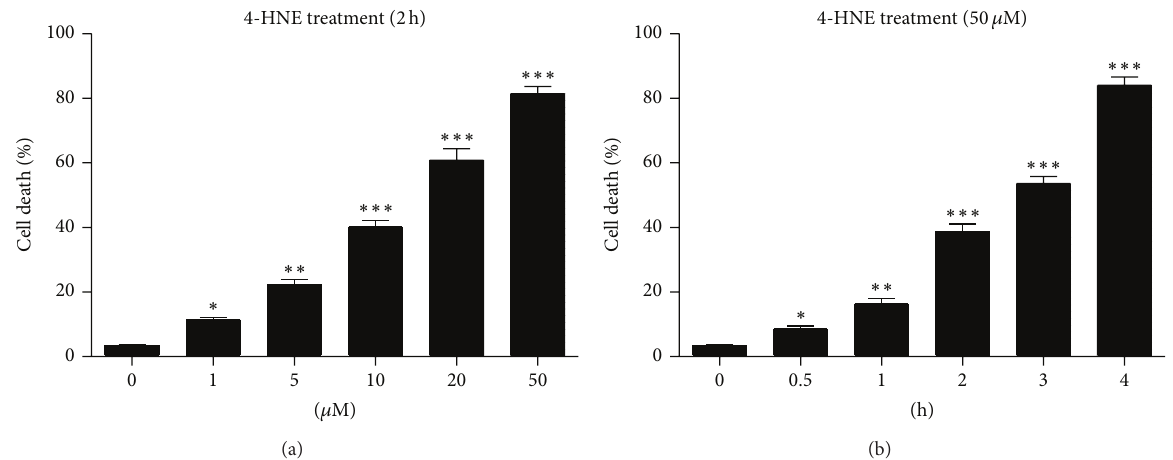
Figure 1: 4-HNE induces cell apoptosis in MG63 cells. (a) Histograms showing the quantification of the cell death (%) in MG63 cells after 4-HNE treatment for 2 h and recovery for another 2 h. The final concentration of 4-HNE ranges from 1 to 50 𝜇 M. Results are averages of three independent experiments. (b) Histograms showing the quantification of the cell death (%) in MG63 cells after 50 𝜇 M 4-HNE treatment for different time points, from 0.5 to 4 h. Results are averages of three independent experiments.